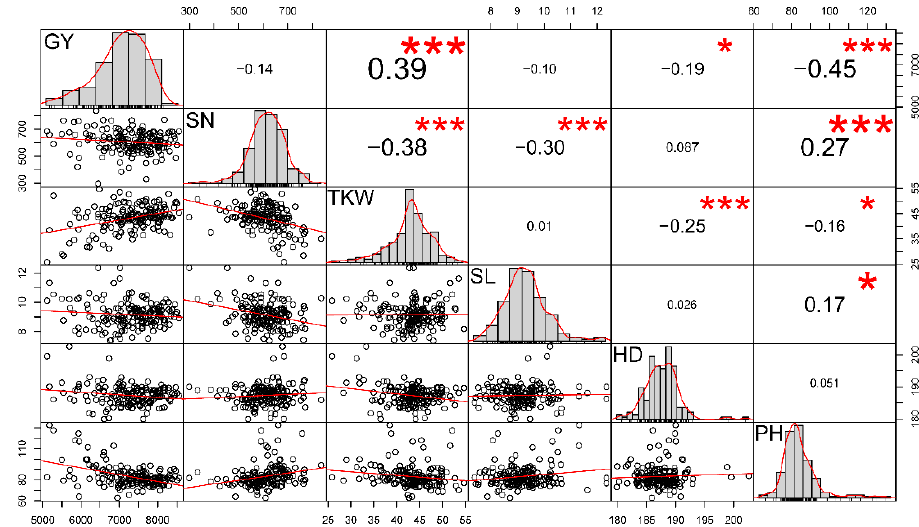
Figure 1. Pearson’s correlation matrix among yield and yield-related traits based on their best linear unbiased estimates (BLUE). The upper corner represents the correlation coefficient, with the significance level indicated by asterisks. Three symbols (“*” and “***”) correspond to three p -values (0.05 and 0.001, respectively). The lower corner contains bivariate scatter plots with fitted lines. The diagonally arranged plots show the phenotypic distribution of traits based on BLUE values. GY, indicates grain yield; SN, spike number per square meter; TKW, thousand-kernel weight; SL, spike length; HD, heading days; PH, plant height.